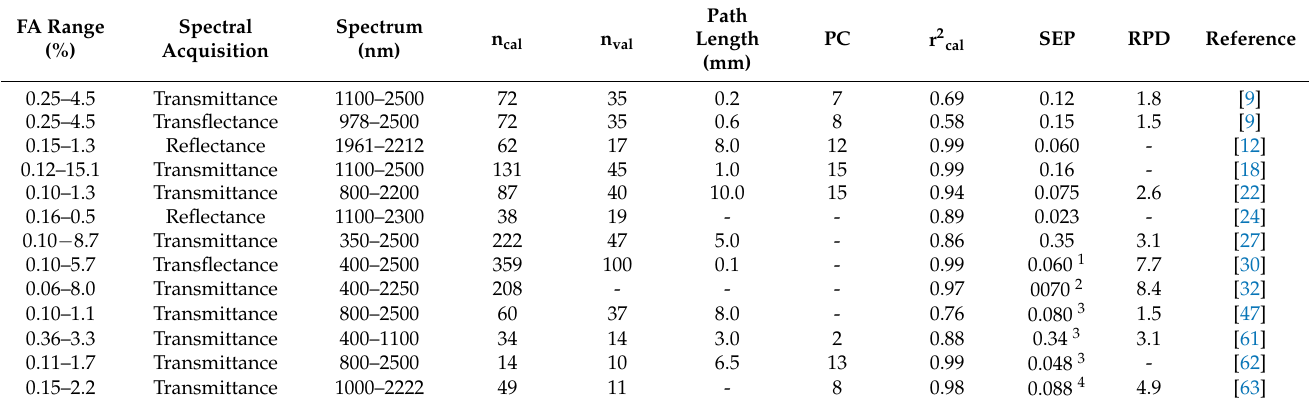
Table 2. PLS statistics obtained for free acidity (FA) of olive oils using different FA ranges, visible/NIR spectral intervals and optical path lengths.